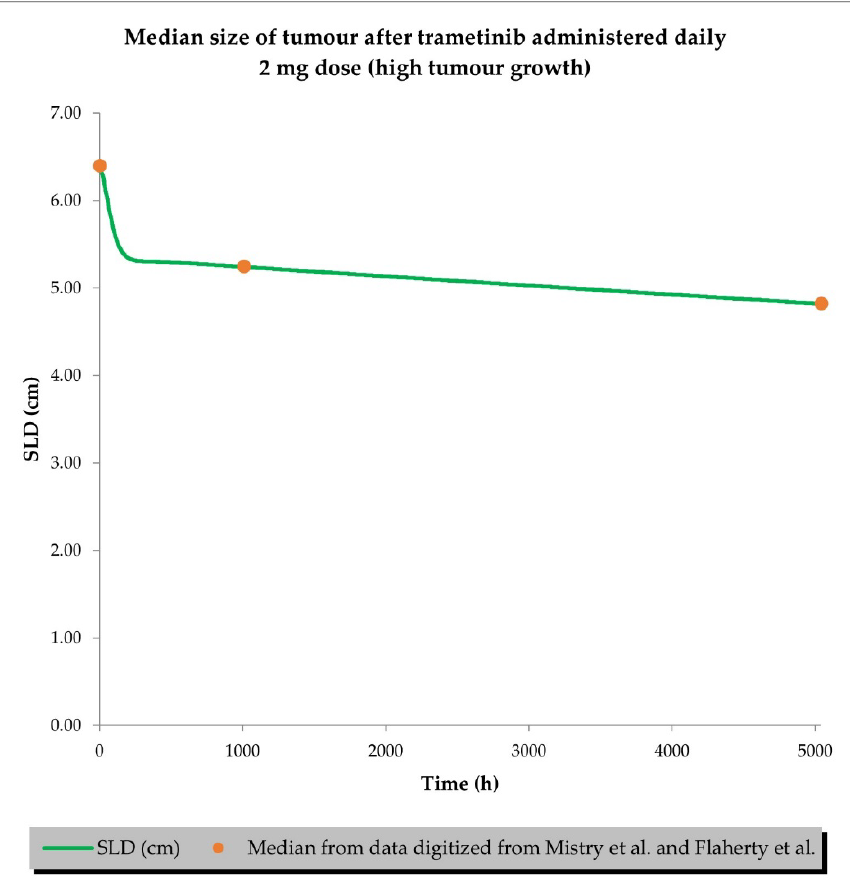
Figure 8. TGI model of trametinib administered daily in cancer patient representatives ( n = 1) with assumption of high tumour growth (kgh = 0.00028 1/h). Observed data are presented as medians from literature data (data digitised from Mistry et al. [34] and Flaherty et al. [35]).